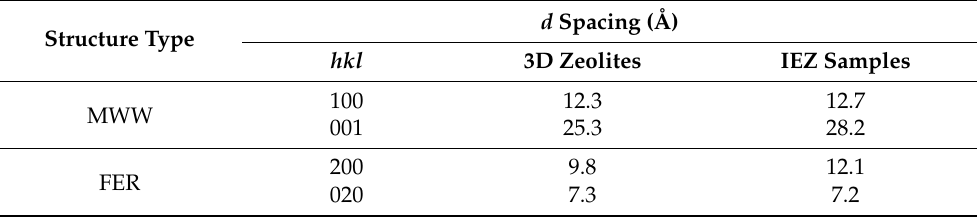
Figure 7. Selected-area electron diffraction patterns of ( A ) 3D MWW (left), IEZ-Ti-MWW (right) and ( B ) 3D-FER (left), IEZ-FER (right). Reprinted with permission from ref. [36]. Copyright 2008, American Chemical Society. Table 4. d spacing determined by HRTEM for 3D zeolites after calcination and IEZ samples. Reprinted with permission from ref. [36]. Copyright 2008, American Chemical